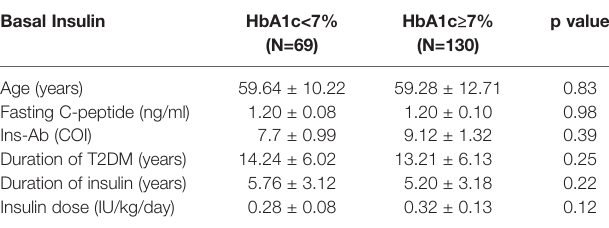
Data was shown as mean ± SD. HbA1c, glycated haemoglobin; Ins-Ab, insulin antibody; COI, OD/CO; OD, absorbance; CO, average absorbance of negative control; The reference range of normal values for antibody is <1 COI.